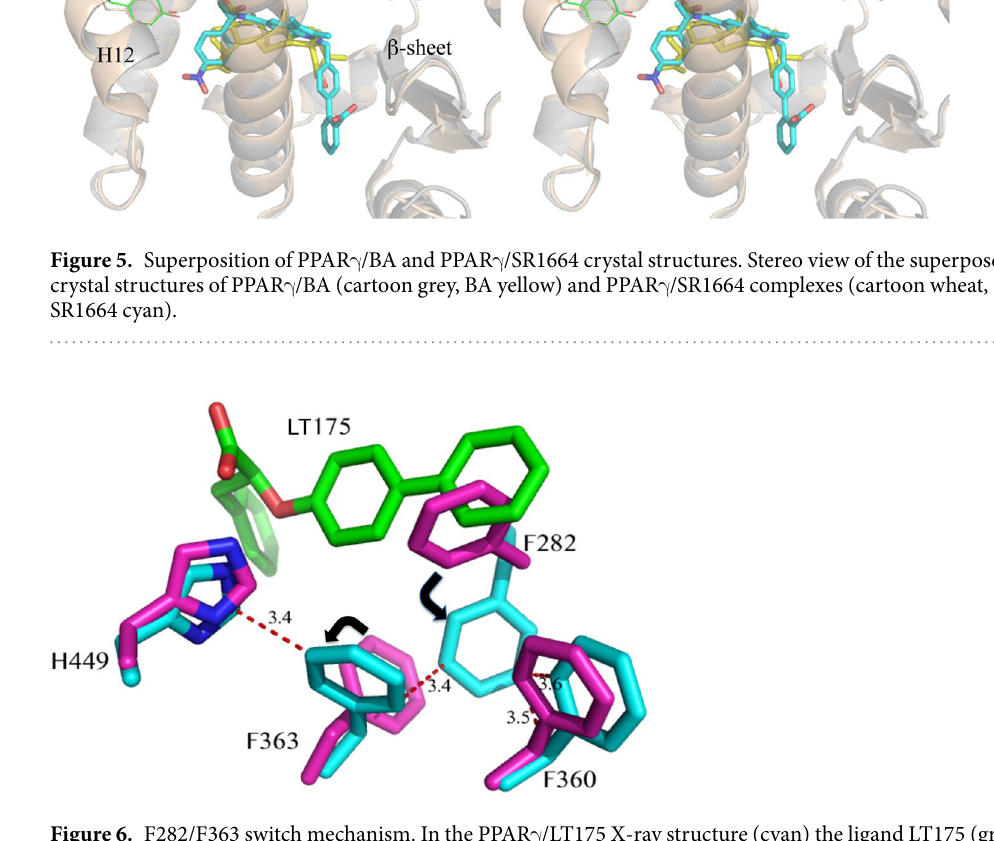
Figure 6. F282/F363 switch mechanism. In the PPAR γ /LT175 X-ray structure (cyan) the ligand LT175 (green) forces the F282 side-chain to switch from the trans to the gauche * conformation, and in turn the F363 side- chain also changes its conformation by 180°, contacting H449. In the new conformation, the F282 aromatic ring makes favourable pi-stacking interactions with the rings of F360 and F363. Apo-PPAR γ residues are in